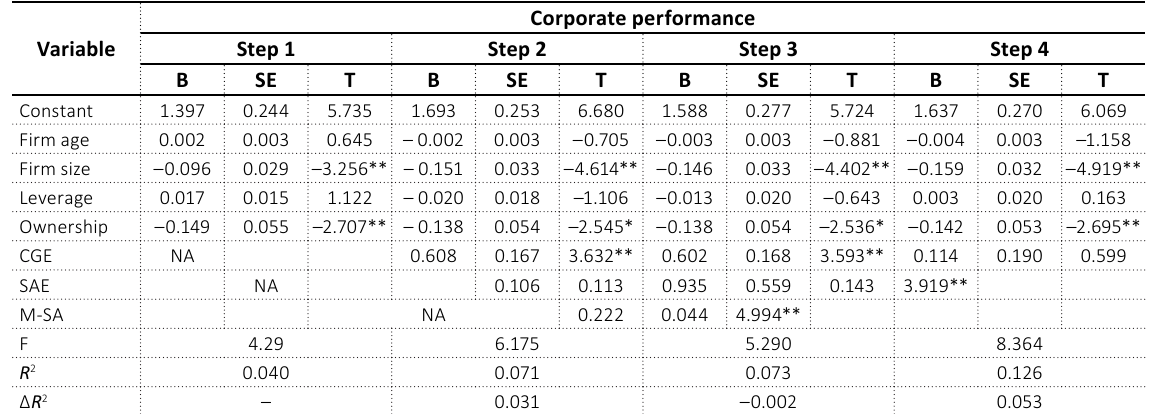
Table 2. The results of the multivariate weighted least-squares regression analysis of four steps Variable Firm age Firm